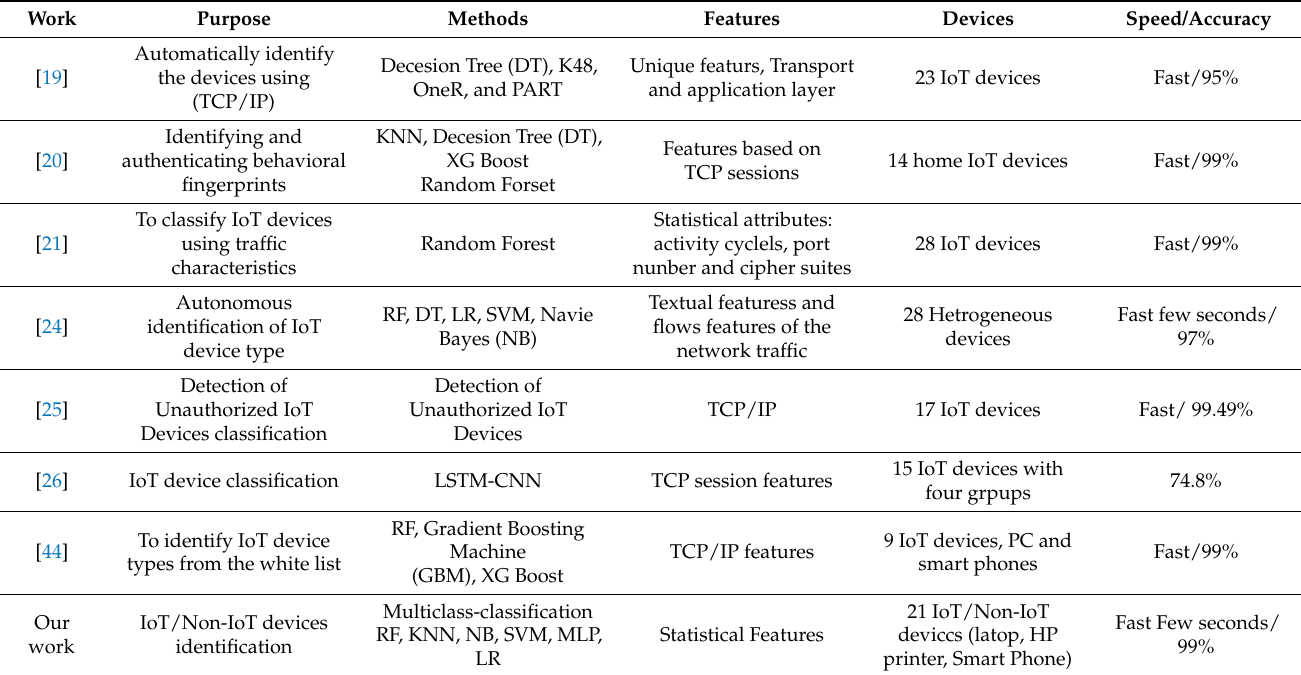
Table 8. Comparison of the proposed work with state-of-the-art